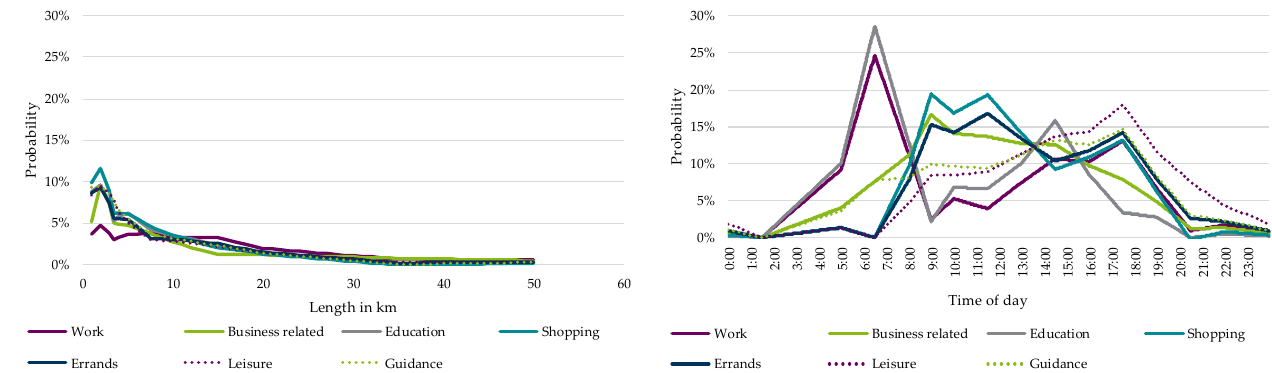
Figure A6. Left : Probability distribution of the length of the routes per vehicle according to the pur- pose of the route. Right : Probability distribution of the time of departure of a vehicle according to the purpose of the route based on data published in [27] for “Rural Region: Small-town Area, Village Area”.